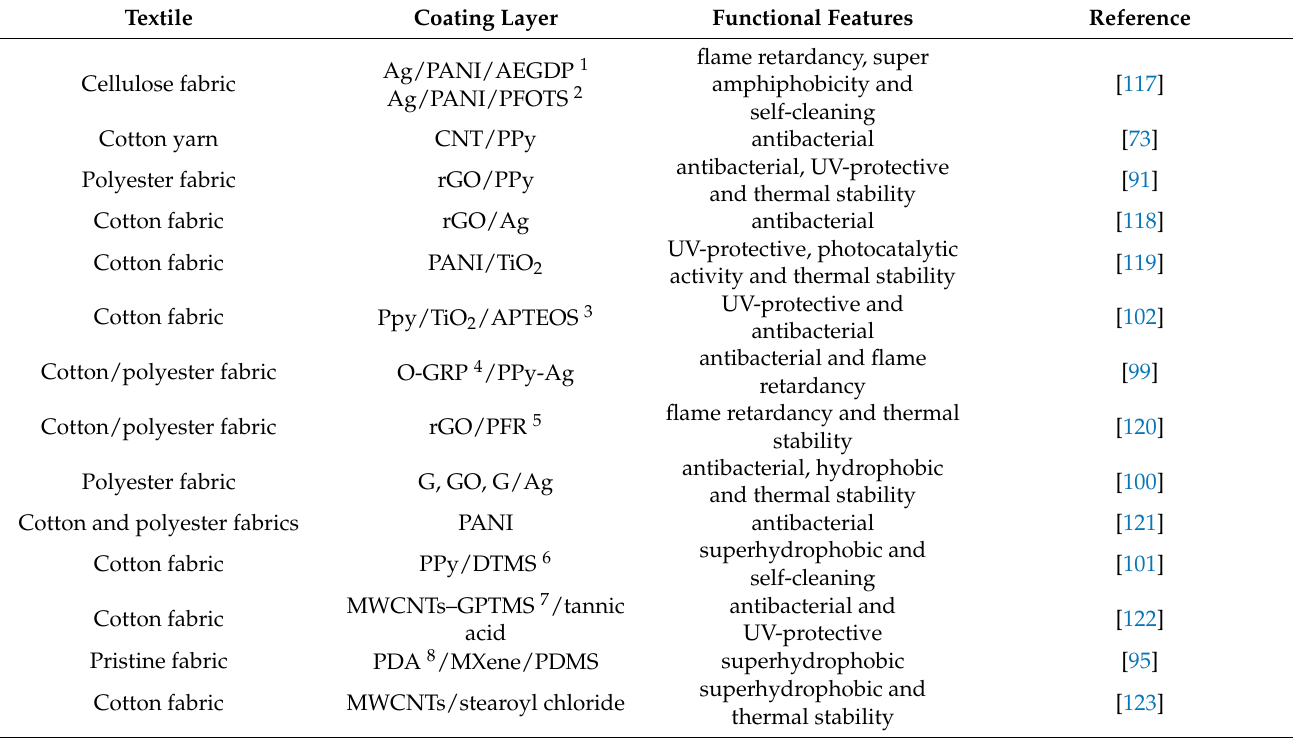
Table 5. Overview of multifunctional electro-conductive textiles utilizing the dip-coating technique. Textile Coating Layer Functional